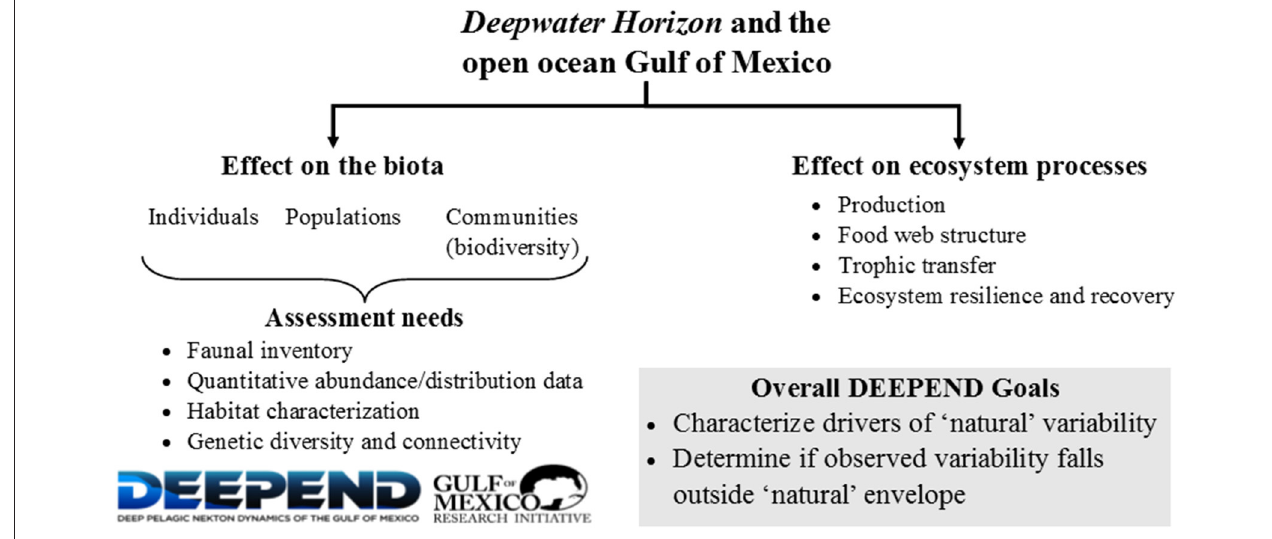
FIGURE 1 | The conceptual framework of the DEEPEND research